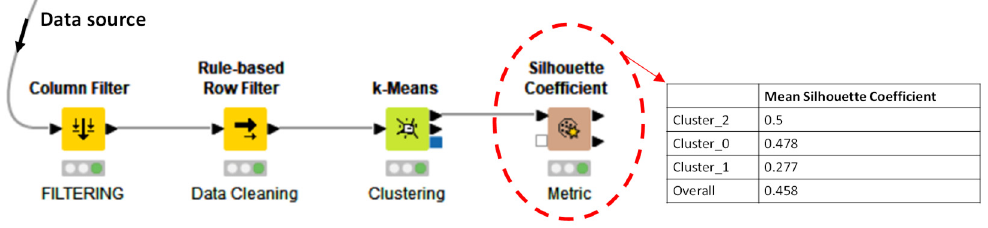
Figure A2. KNIME workflow implementing Silhouette Coefficient estimating clustering perfor- mance.